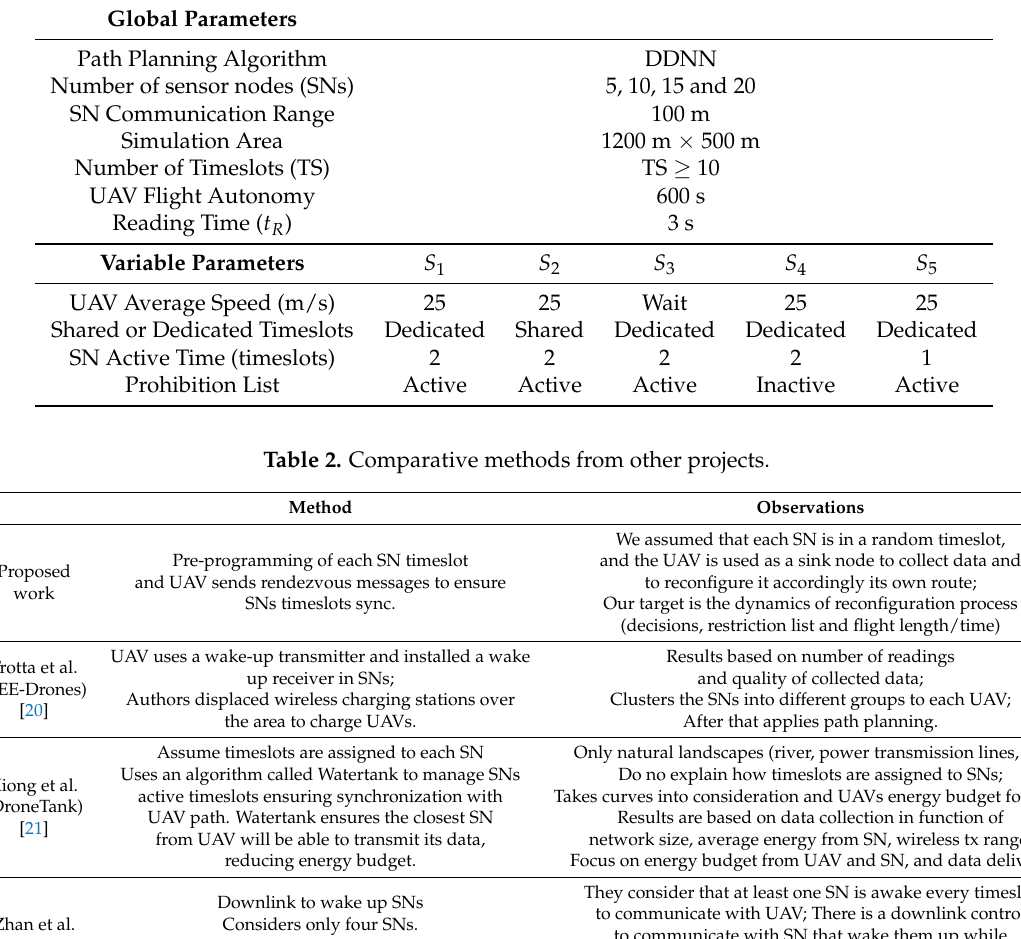
Table 1. Specification of Simulation Scenarios.